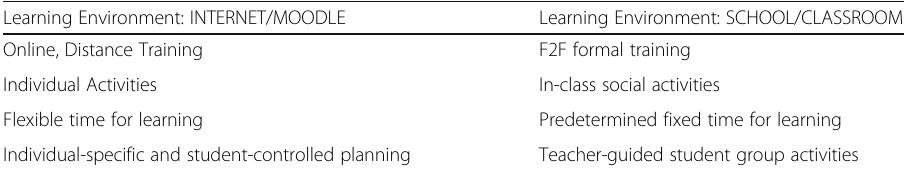
Table 1 BLENDING of online and face – to-face environments Learning Environment: